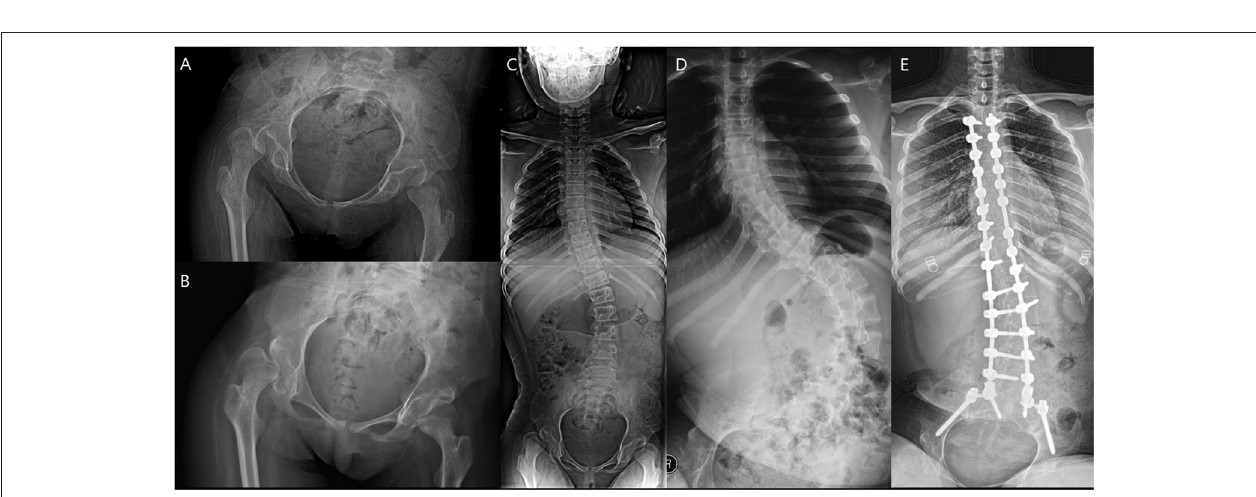
FIGURE 7 | A patient who underwent spinal fusion after the index surgery. (A) Preoperative hip. (B) Hip 1 year after surgery. (C) Preoperative spine. (D) Aggravated scoliosis 1 year after surgery. (E) Spinal fusion performed 4 years after the index